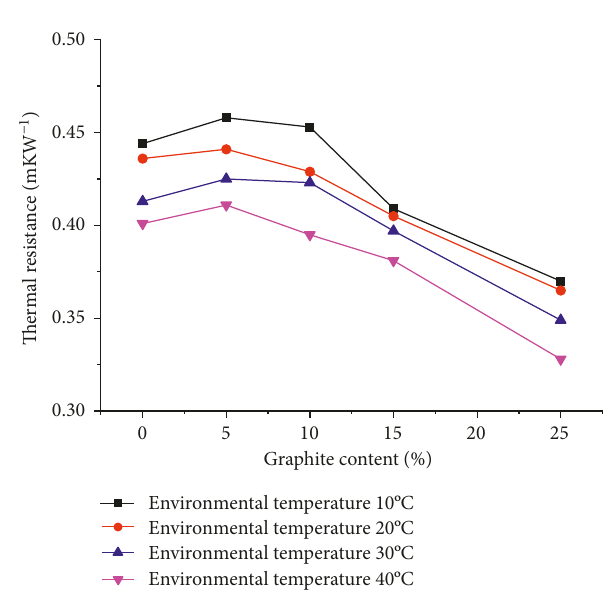
Figure 8: Thermal resistance of energy pile system for different graphite volumetric